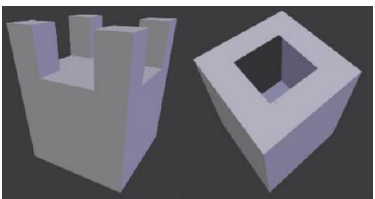
Figure 2. Sample Objects created from Blender (a) Building with minarets (b) Building with centre courtyard